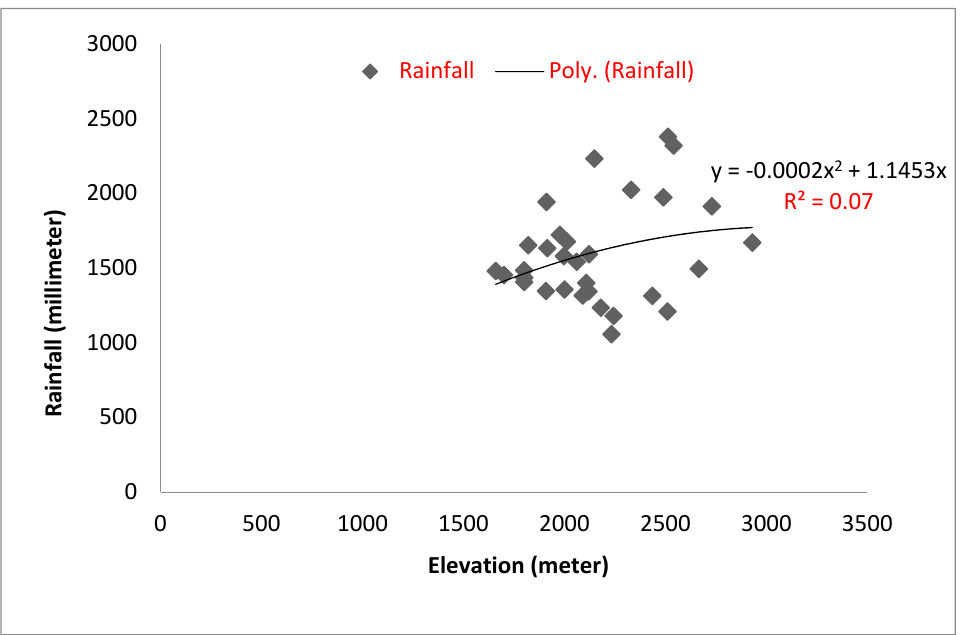
Figure 5. The association between the mean annual total rainfall and elevation.